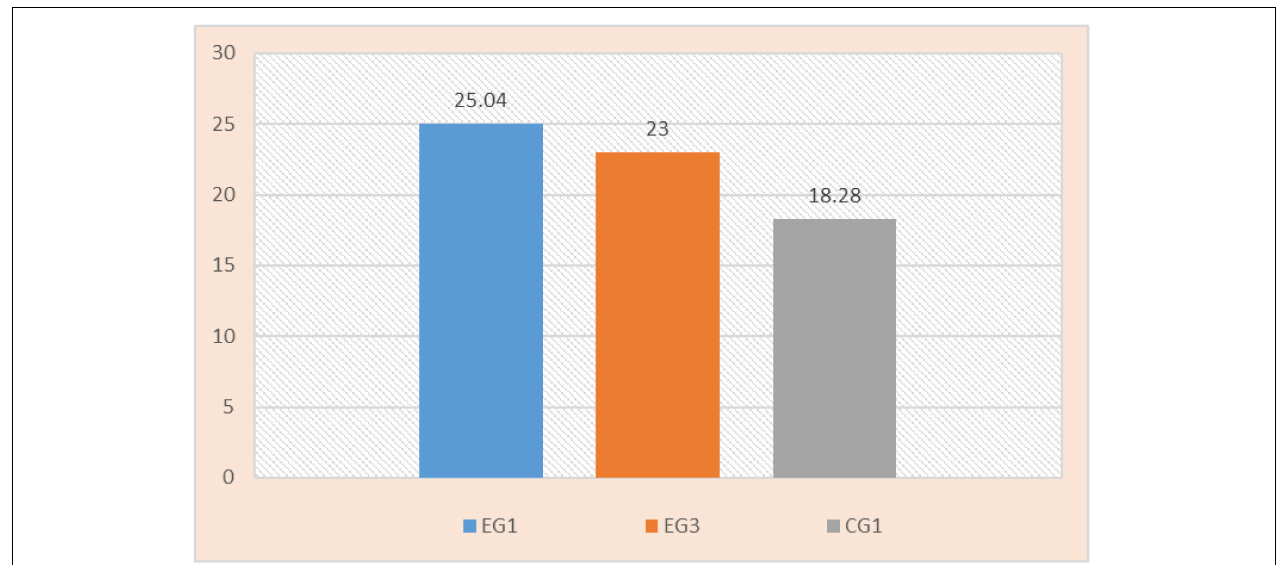
FIGURE 1 | Post-test mean scores of the groups with different ± pre-test and ± treatment conditions.